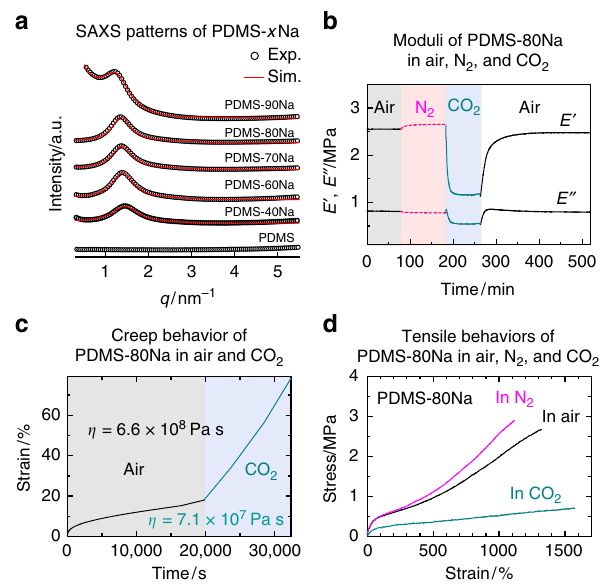
Fig. 2 Effect of CO 2 on mechanical properties of PDMS-80Na. a Experimental and simulated SAXS patterns for PDMS- x Na. b Effect of each gas on the storage modulus ( E ’ ) and loss modulus ( E ” ) for PDMS- 80Na measured at 1 Hz and 30 °C. c Creep test for PDMS-80Na measured at a stress of 4 kPa at 30 °C. Air fl ow is changed to CO 2 gas fl ow. d Tensile tests for PDMS-80Na measured at 27 ± 1 °C in air, in N 2 , and in CO 2 . The stretching speed is 100 mm min −